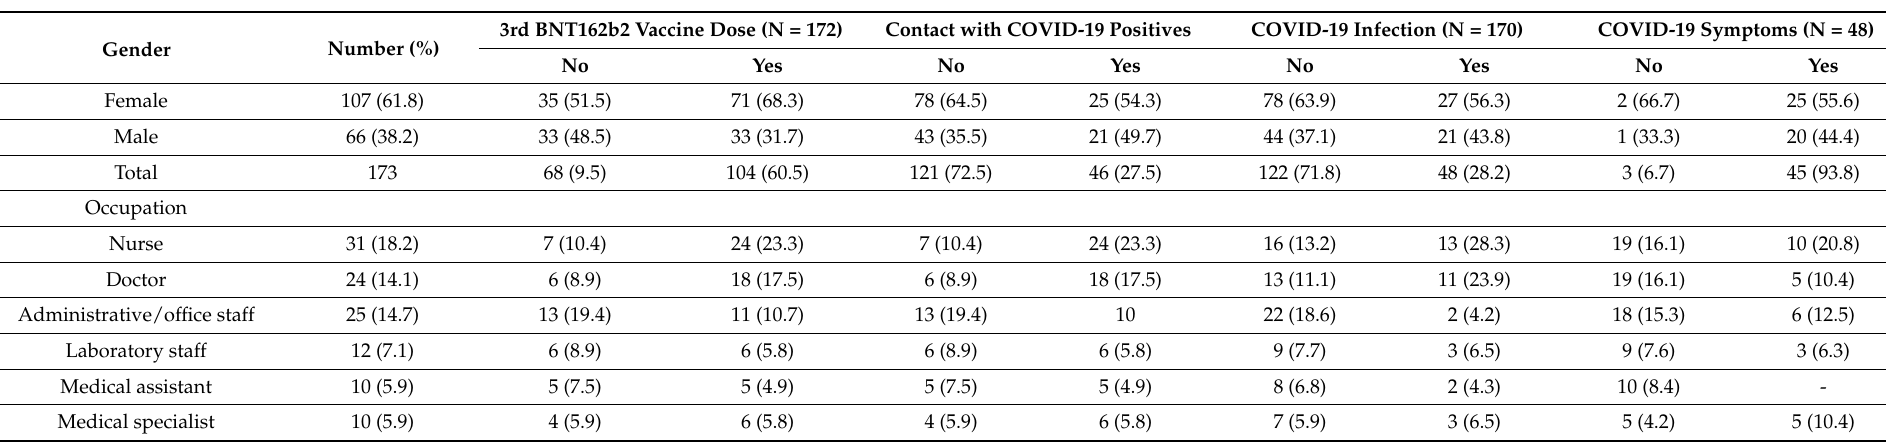
Table 3. Prevalence of SARS-CoV-2 infection and third dose vaccination status in different genders and occupations [Quantitative data are presented as number